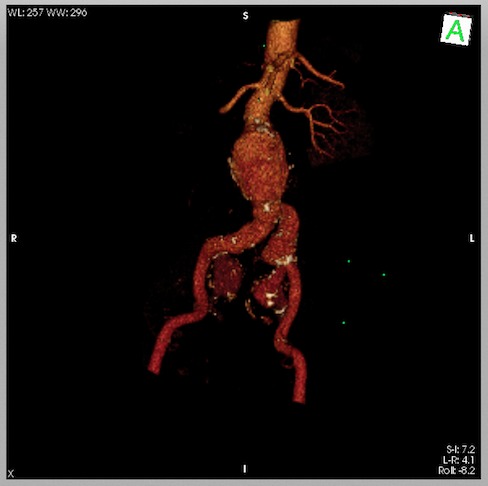
Preoperative angiotomography in 3D reconstruction.